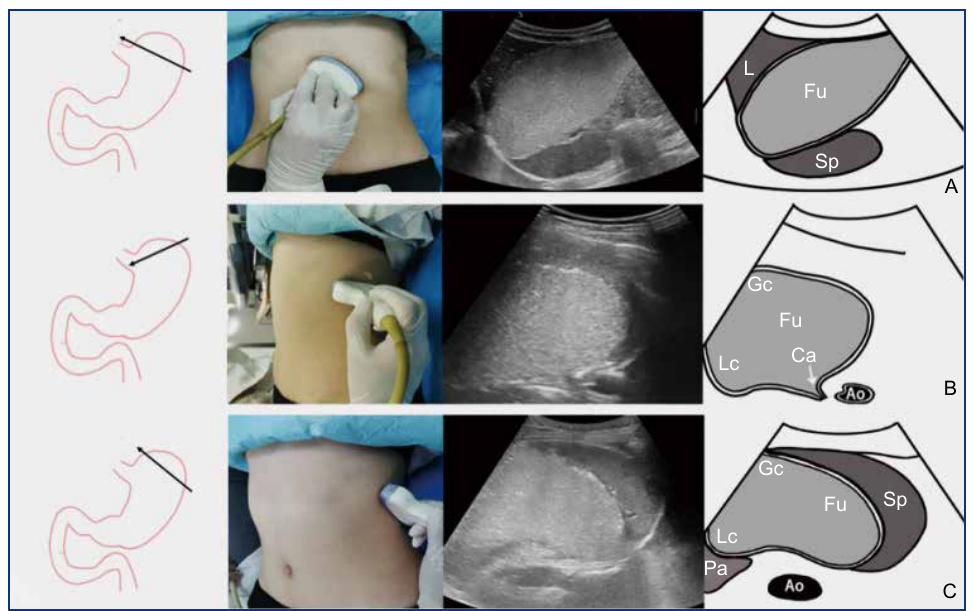
Figure 3 The imaging sections of the fundus. (A) In supine position, the transducer was placed under the xiphoid and left hypochondrium; (B and C) In supine position, the transducer was placed in intercostal. L, liver; Fu, fundus; SP, spleen; Gc, greater curvature; Lc, lesser curvature; Ca, cardia; AO, abdominal aorta; Pa,